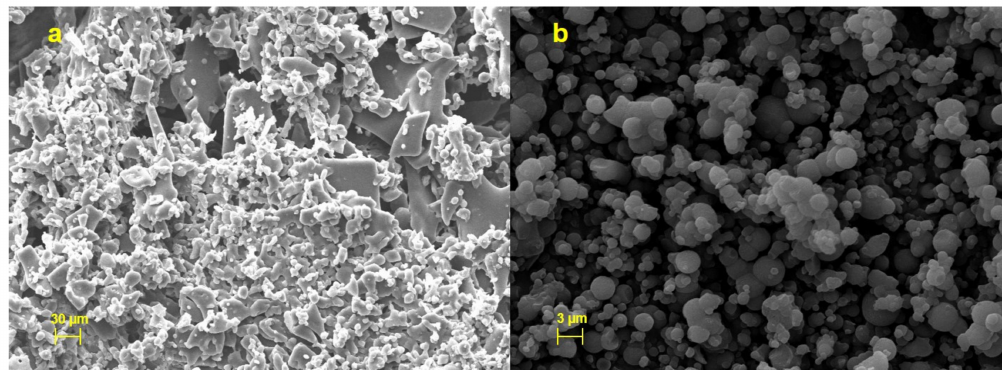
Figure 7. SEM images of HSE ( a ) and CM-HSE ( b ) after 6 months of harsh storage conditions.